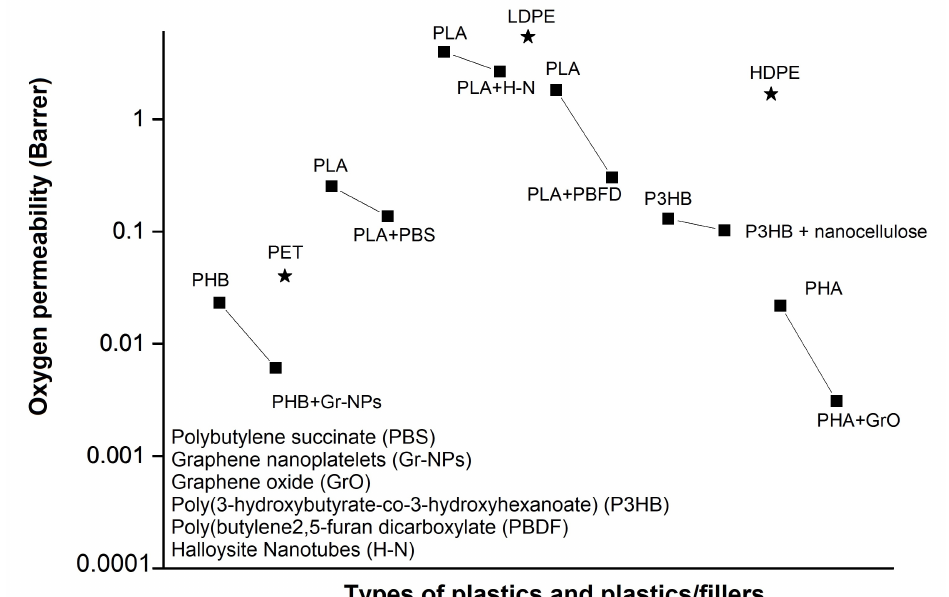
Figure 5. Effect of nanofillers on oxygen permeability of various